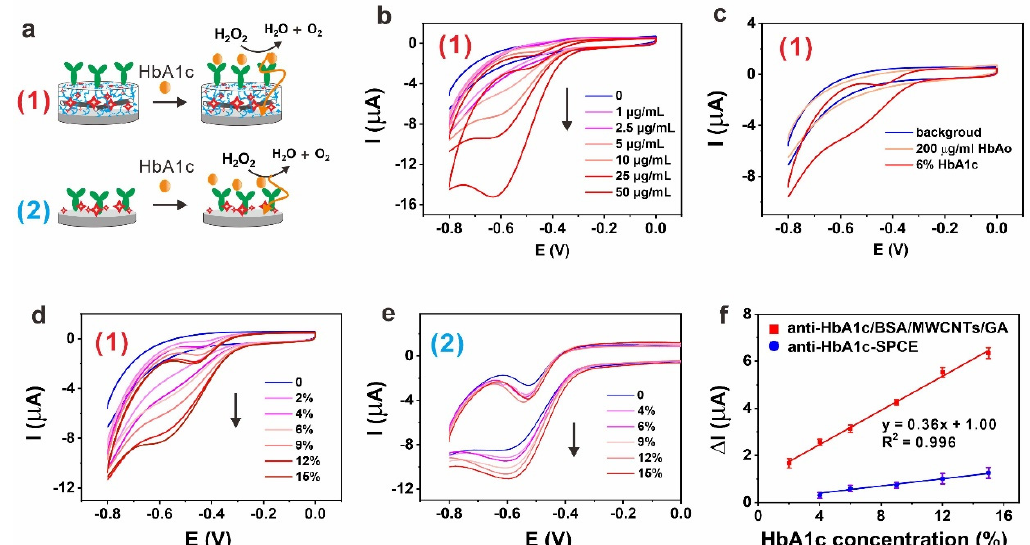
Figure 2. ( a ) Schematic illustration of anti-Hb1Ac-BSA/MWCNTs/GA layer (1) and anti-HbA1c layer (2) for selective sensing of HbA1c; ( b ) CV curves of the anti-HbA1c-BSA/MWCNTs/GA layer in the detection of different concentrations of HbA1c (no HbAo). (n = 3, only one CV plot for each condition is shown); ( c ) CV curve of the anti-HbA1c-BSA/MWCNTs/GA layer in the detection of HbAo and 6% HbA1c. (n = 3, only one CV plot for each condition is shown); ( d ) CV curves of the anti-HbA1c-BSA/MWCNTs/GA layer in the detection of different concentrations of % HbA1c (contain HbAo). (n = 3, only one CV plot for each condition is shown); ( e ) CV curves of the anti-HbA1c layer in the detection of different concentrations of % HbA1c (contain HbAo). (n = 3, only one CV plot for each condition is shown); ( f ) calibration curves as a function of % HbA1c for anti-HbA1c layer and anti-HbA1c-BSA/MWCNTs/GA layer. (n = 3, error bars represent the standard deviation of the mean).